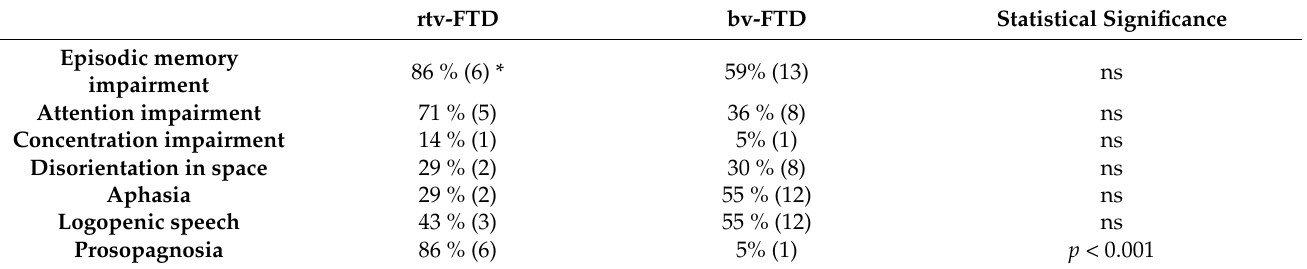
Table 3. Cognitive symptoms in right temporal variant of frontotemporal dementia (rtv-FTD) versus behavioral variant of frontotemporal dementia (bv-FTD) patients in our initial evaluation.